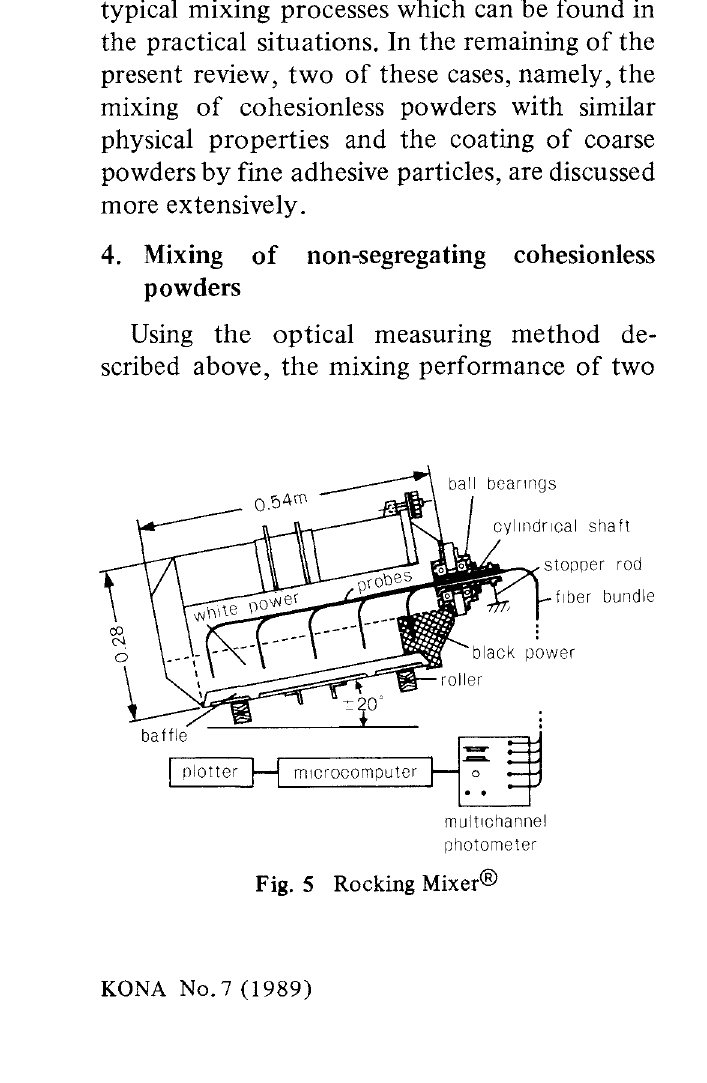
Fig. 6 Influence of rocking speed on mixing time at different rotation